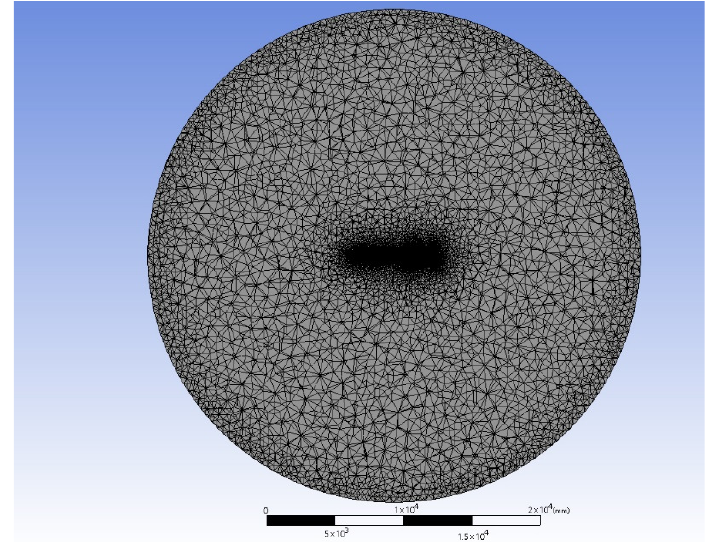
Figure 4. CFD unstructured mesh of the axisymmetric vehicle.